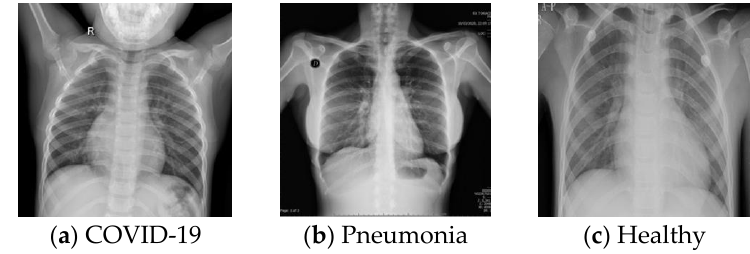
Figure 3. Sample of images from DB3.